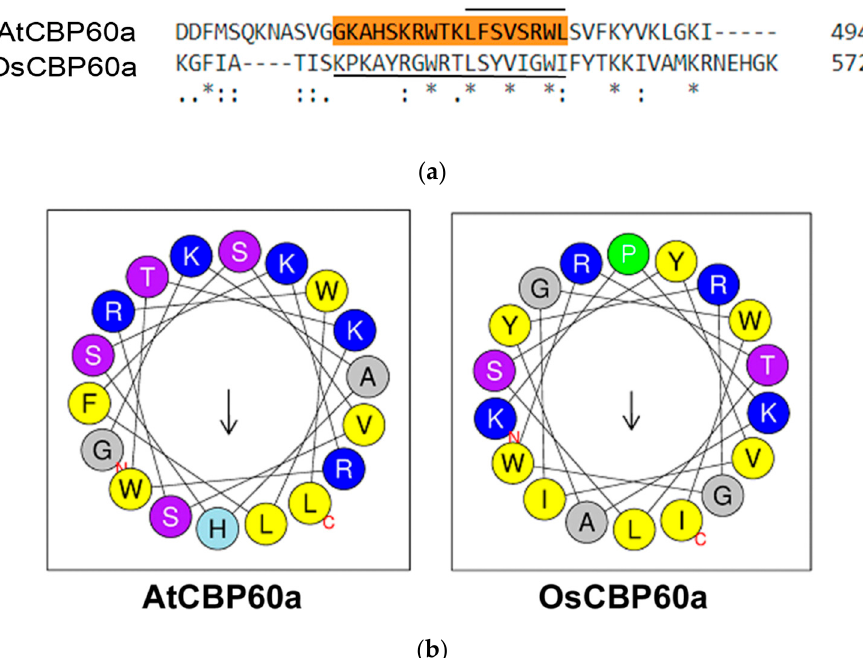
Figure 4. Identification of a CBD in OsCBP60a. ( a ) Multiple sequence alignment (Clustal Omega) of the C-terminus localised CBD of AtCBP60a with the loosely conserved region in the C-termius of OsCBP60a protein. Identical amino acids are indicated by a star, strongly conserved groups by double dots, and weakly conserved groups by dots. The highlighted region in the CBD of AtCBP60a is predicted to form the amphipathic helix shown in ( b ). The overlined residues in AtCBP60a contribute to CBD as determined by mutagenesis [25], while the underlined region in OsCBP60a indicates the predicted CBD. ( b ) Prediction of amphipathic helix in AtCBP60a and OsCBP60a by the Heliquest algorithm. Both proteins show the presence of an amphiphilic alpha helix with majority of positively charged residues lying on one face of the